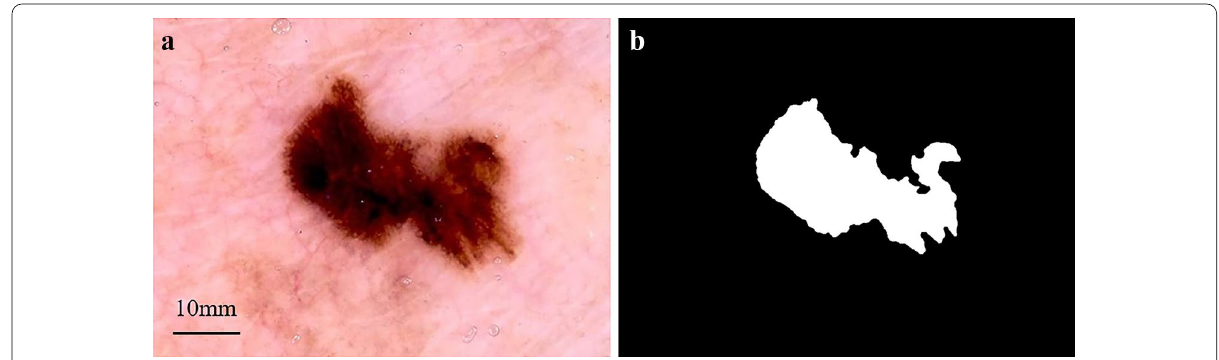
Figure 6 Skin lesion segmentation: ( a ) Dermoscopic image input; ( b ) Binary mask